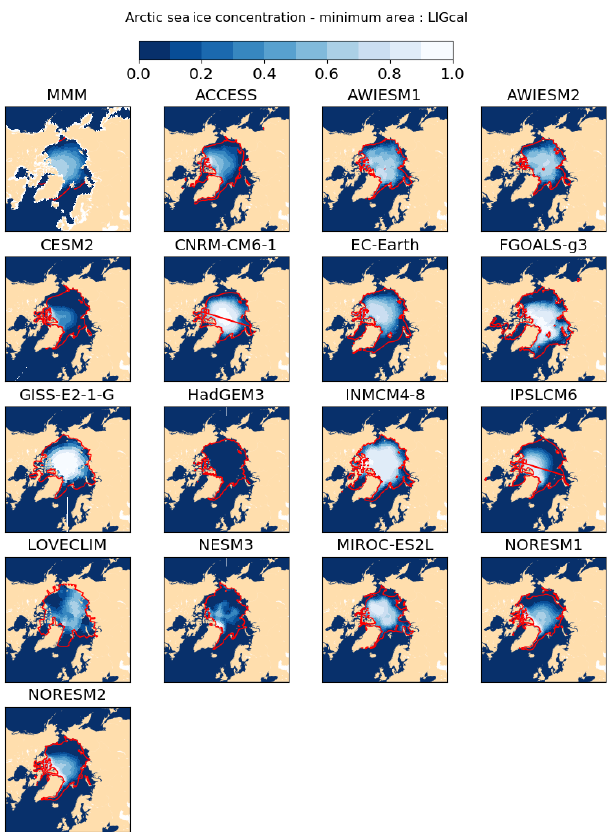
Figure 7. Sea ice annual concentration during the LIG (computed with calendar adjustment), for the multi-model mean (MMM) and for each model. The colour-filling of the symbols on the maps cor- respond to the reconstructed values, classified into three categories: perennial cover (9 to 12 months), seasonal cover (3 to 9 months) and ice-free state (0 to 3 months). On the MMM panel, for each data site, the colour of the symbol outline corresponds to the number of models simulating the reconstructed ice cover. On the panels for individual models, the shape of the symbol depends on the model result being below the reconstructed one (triangle down), above the reconstructed one (triangle up) or in the same category as the recon- structed one (circle). The number of data points which are above, equal and below the number of months simulated by models are written in the bottom-right corner of each